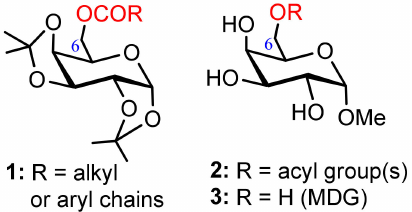
Figure 1. Structure of 1 – 3